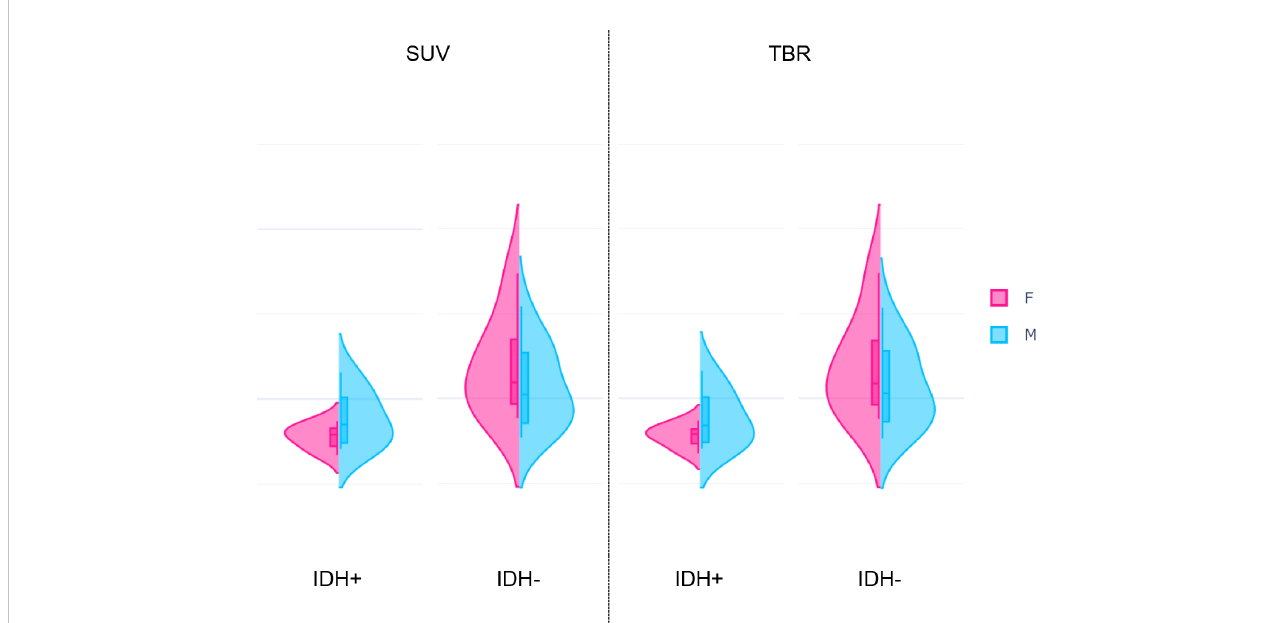
FIGURE 5 Distributions of the highest-ranking Intensity histogram coef fi cient of variation (ih.cov) feature extracted from standardized uptake value (SUV, p =0.0007) and tumor-to-background ratio (TBR, p =0.0003) values of glioma patients. Each plot represents distributions of the feature in female (F) and male (M) patients grouped by the IDH+ (low risk) and IDH- (high risk) mutation statuses.